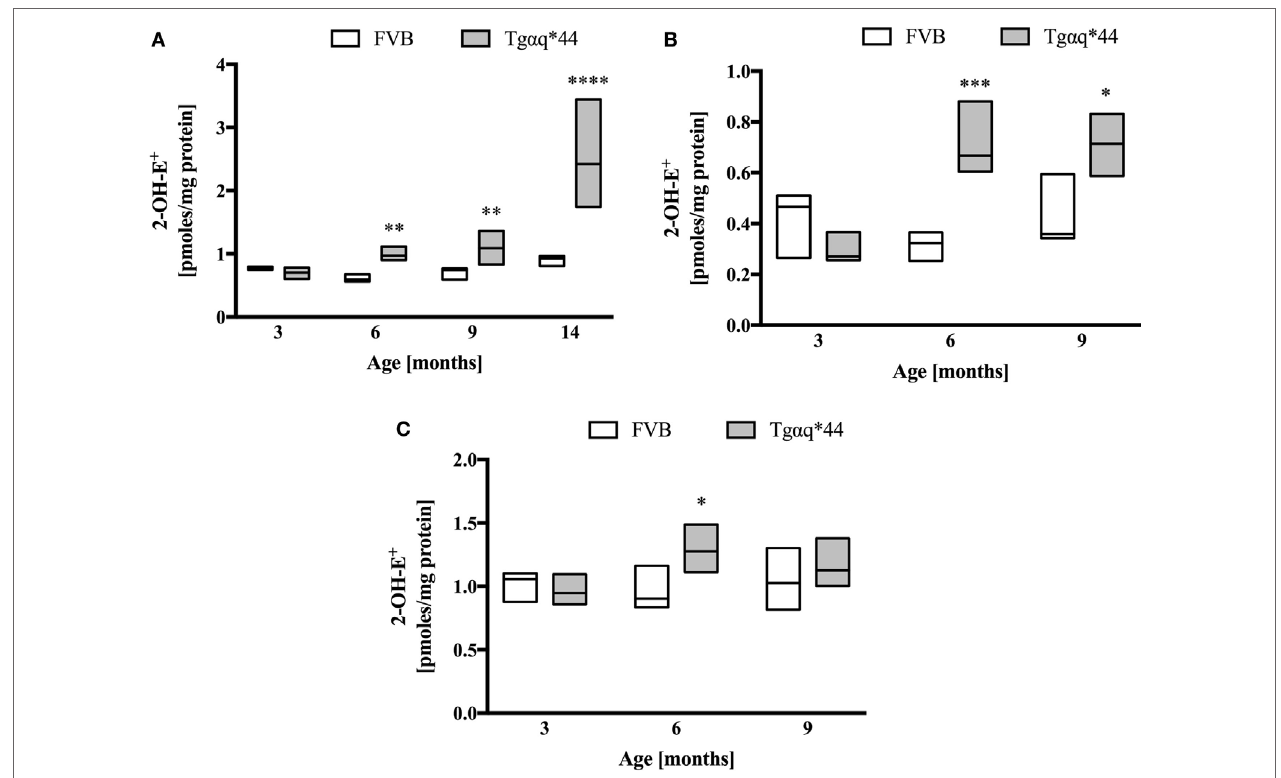
FigUre 7 | Superoxide production in heart homogenates of Tg α q*44 vs FVB mice. (a) Whole heart, (B) left ventricle and septum, and (c) right ventricle. Tissue samples were incubated with dihydroethidium, followed by superoxide-specific 2-hydroxyethiudium (2-OH-E + ) detection using high performance liquid chromatography, as described in Section “Materials and Methods.” Data represent median ± IQR. Results presented as median ± IQR. Statistical significance in panel (a) for aged-matched groups was assessed using the non-parametric Mann–Whitney U test, N = 5–6 hearts (3- to 9-month-old groups) and N = 8–11 (14-month-old group). In panels (B,c) , statistical significance in aged-matched groups was assessed using the non-parametric Mann–Whitney test (for 3-month-old mice) or unpaired two-tailed t -test (all other), N = 5 hearts per group; * P < 0.05, ** P < 0.01, and *** P <